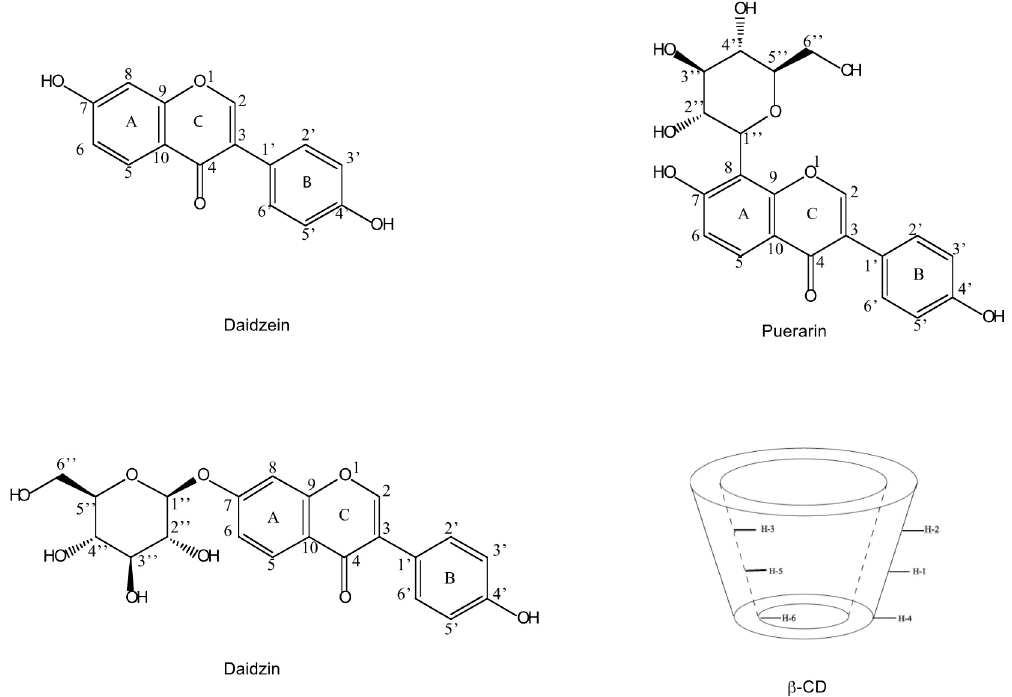
Figure 1. Structures of daidzein ( 1 ), daidzin ( 2 ) and puerarin ( 3 ) and a schematic representation of β -CD.